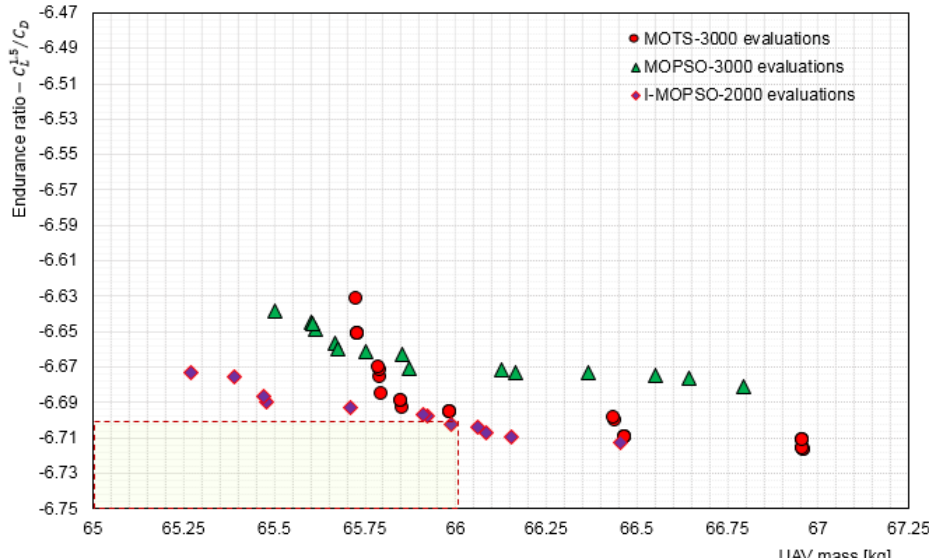
Figure 17. Comparison of Pareto front using MOTS and MOPSO for 3000 evaluations, and with I-MOPSO for 1000 evaluations.